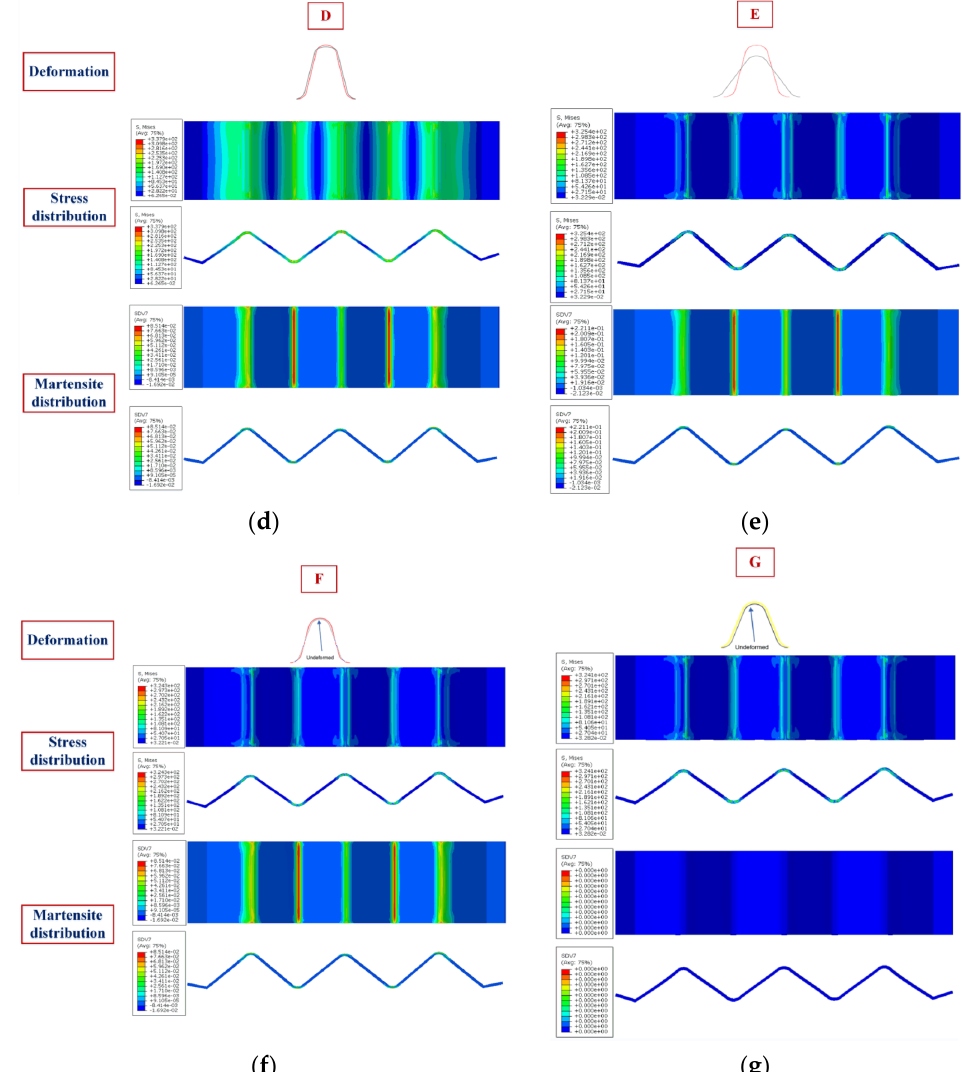
Figure 9. Deformation and phase transition characteristics of NiTi alloy corrugated sample: ( a ) Sample section; ( b ) Deformation process of point B in Figure 8; ( c ) Deformation process of point C in Figure 8; ( d ) Deformation process of point D in Figure 8; ( e ) Deformation process of point E in Figure 8; ( f ) Deformation process of point F in Figure 8; ( g ) Deformation process of point G in Figure 8.